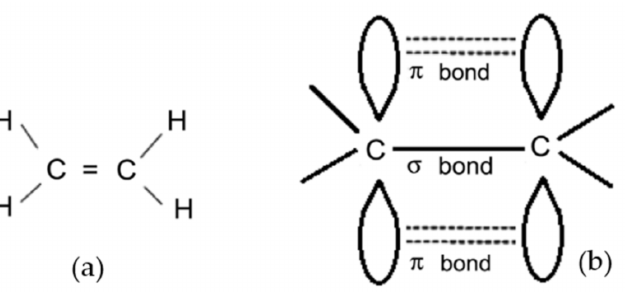
Figure 2. ( a ) chemical structure of ethylene, ( b ) σ and π bonds. Reprinted with permission from ref. [54]. Copyright 2017